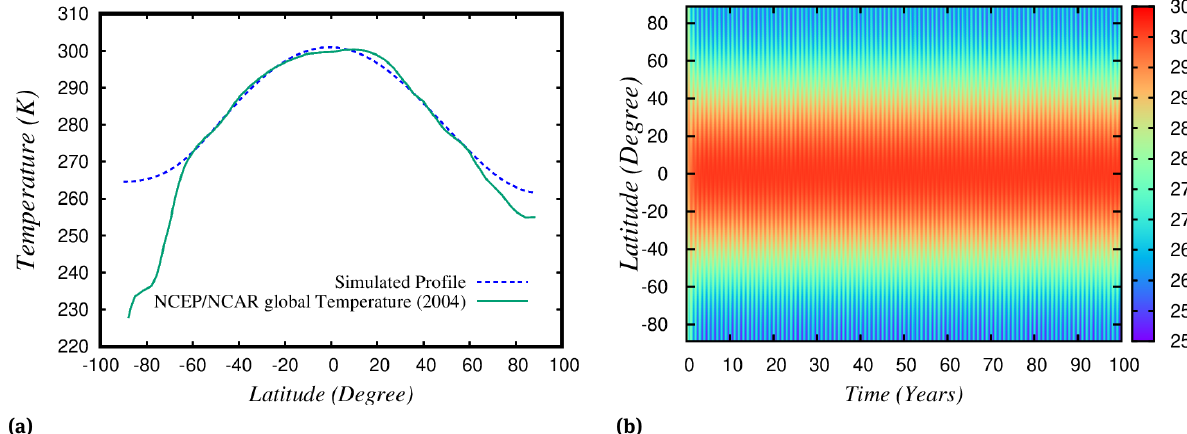
Figure B1. (a) Comparing real mean data of the temperature in different latitudes of the Earth with the simulation data of a planet in an Earth/Sun-like system. (b) Temperature profile of simulated data for different latitudes for a one hundred year